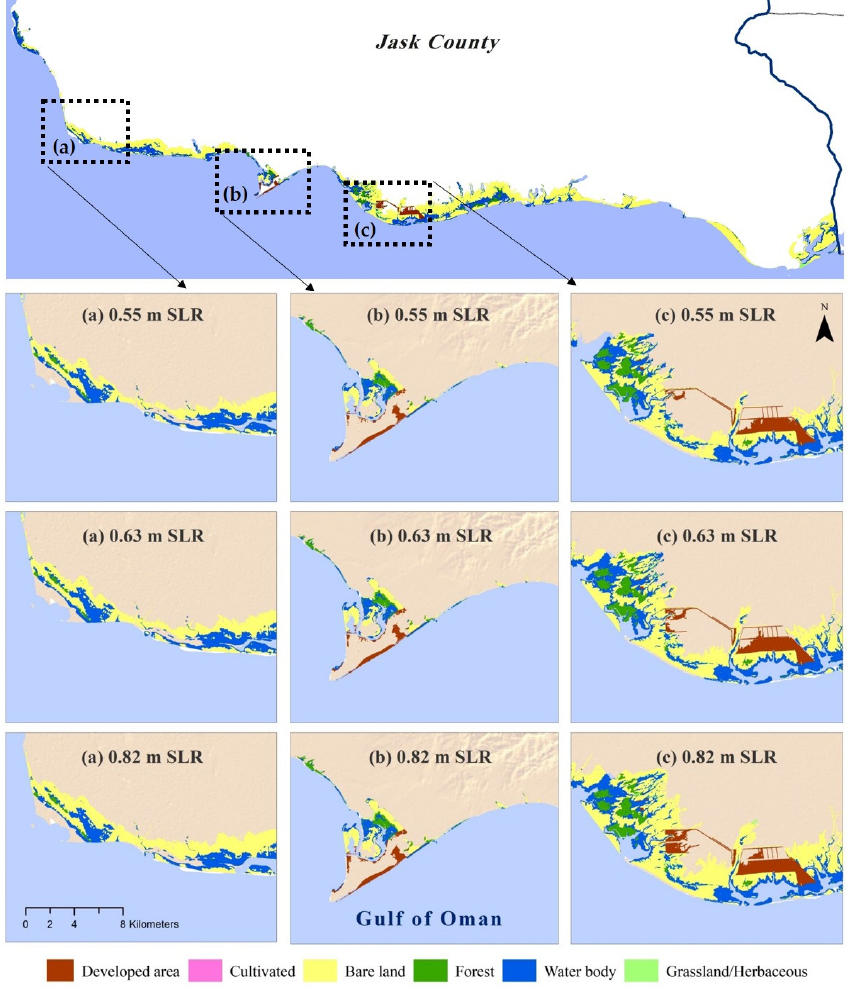
Figure 6. Examples of land cover inundation along the northern coast of the Gulf of Oman due to 0.55, 0.63, and 0.82 m of sea-level rise by 2100.